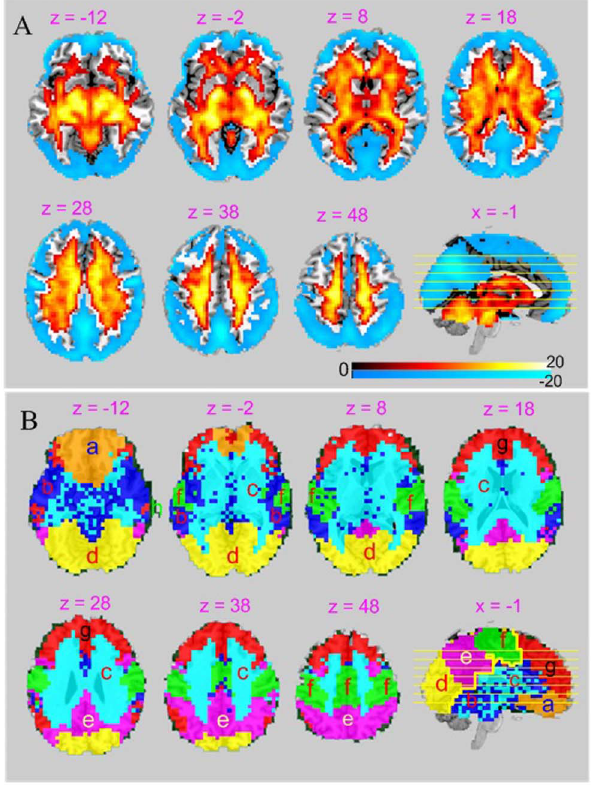
Figure 3. Spatial distribution and regional organization of BEN. A) The statistically defined higher-than-average BEN network (hot color) and lower-than-average BEN network (cool color). The significance level used for thresholding the distribution map (the statistical parametric map of the student t-test) is p , 0.01 (corrected for multiple comparison); B) The 8 BEN clusters identified by clustering: a) OFC, b) TPLS, c) WM, d) VIS, e) DMN, f) MC, g) PFC, h) peripheral artifact. The text above each axial slice in B, C, and D indicates the slice location (z and x mean the x and z coordinate in mm, respectively) in the MNI space. The left side of image corresponds to the left side of